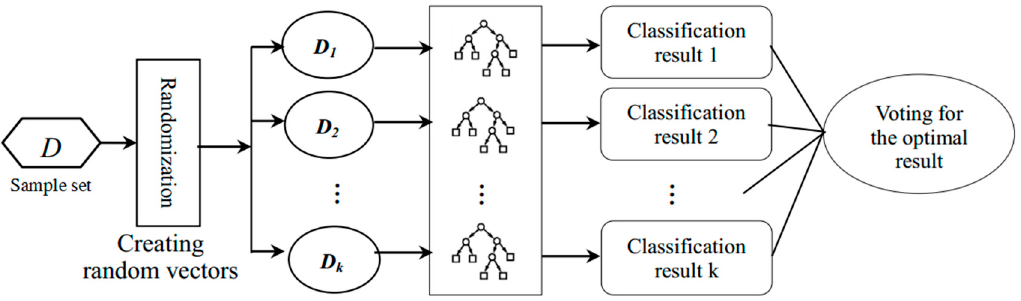
Figure 1. Random forest operating principle.